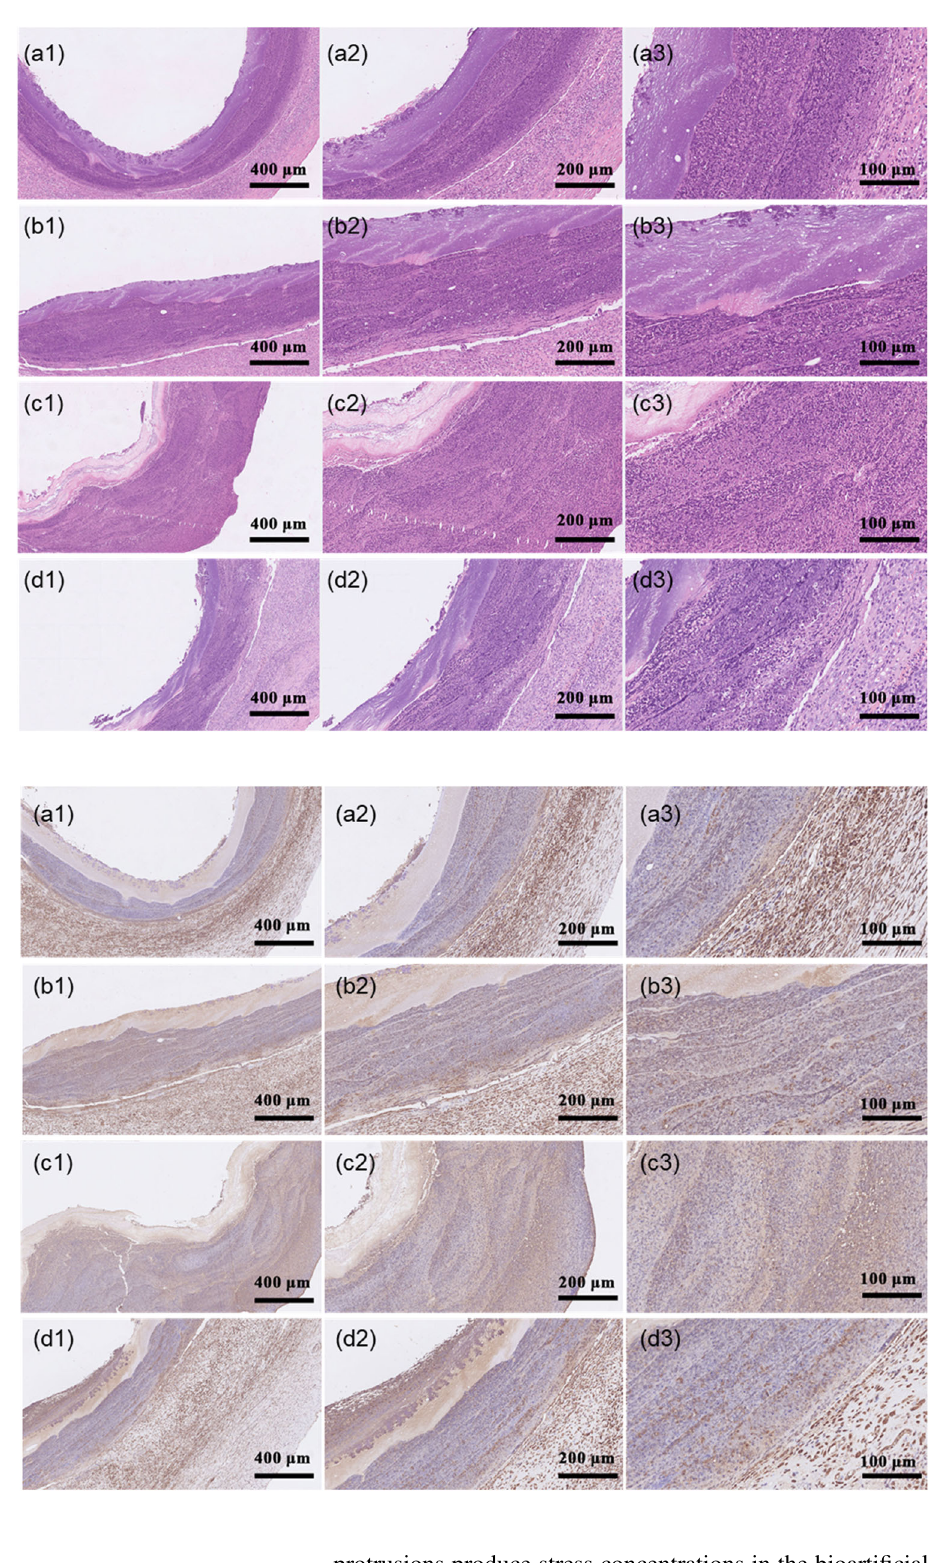
Fig. 13 HE staining on bioarti fi cial blood vessels (100x, 200x, and 400x magni fi cation): a1 – a3 Pig blood vessel. b1 –